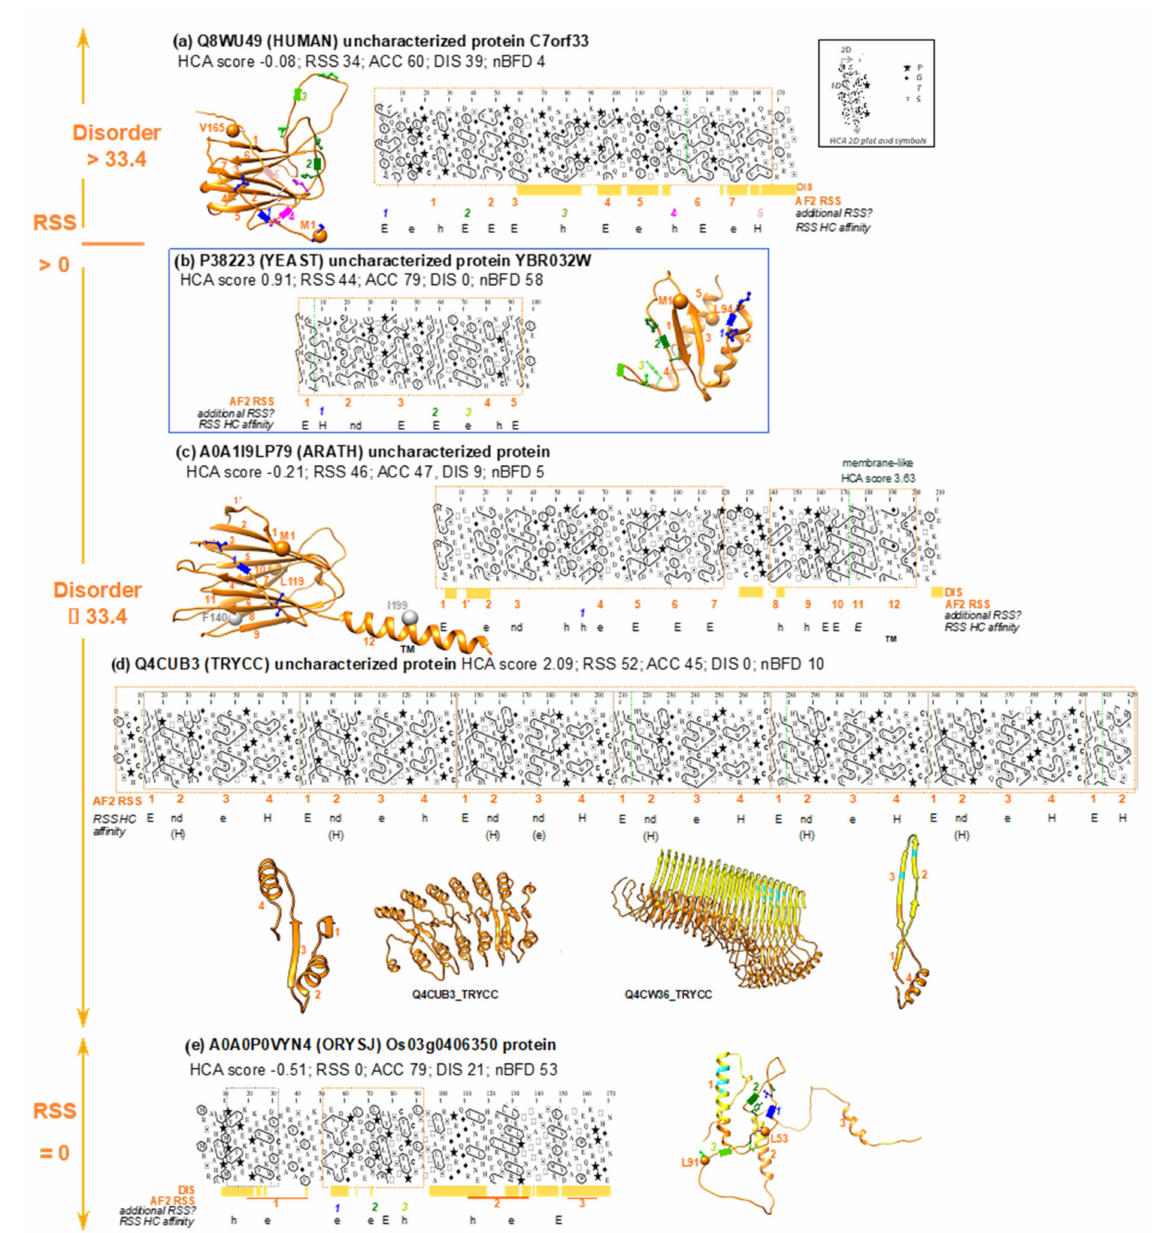
Figure 7. Examples of full-VL soluble-like foldable segments corresponding to folded AF2 predictions. Examples were extracted from the binary tree diagram shown in Figure 5. AF2 3D structure models, colored according to the pLDDT values, are shown, along with the positions of the first and last amino acids of the full-VL soluble-like foldable segments (orange balls). The values of the four features are indicated, along with the HCA scores. HCA plots of sequences of the full-VL soluble-like foldable segments are also shown (orange, dashed boxes). How to read sequences (1D) and secondary structures (2D) is shown in the inset, as well as the special symbols used to designate four amino acids with respect to their particular structural behavior. Regular secondary structures (RSS), as observed in the AF2 3D structure models, are designated with orange numbers, which are also reported below the HCA plot in order to indicate the correspondence with hydrophobic clusters. RSS predicted only according to the presence of hydrophobic clusters are reported in other colors, and their positions are indicated on the AF2 3D structure models (with the first and last amino acids shown in atomic details). The hydrophobic cluster affinities for RSSs, calculated using only the binary pattern information,